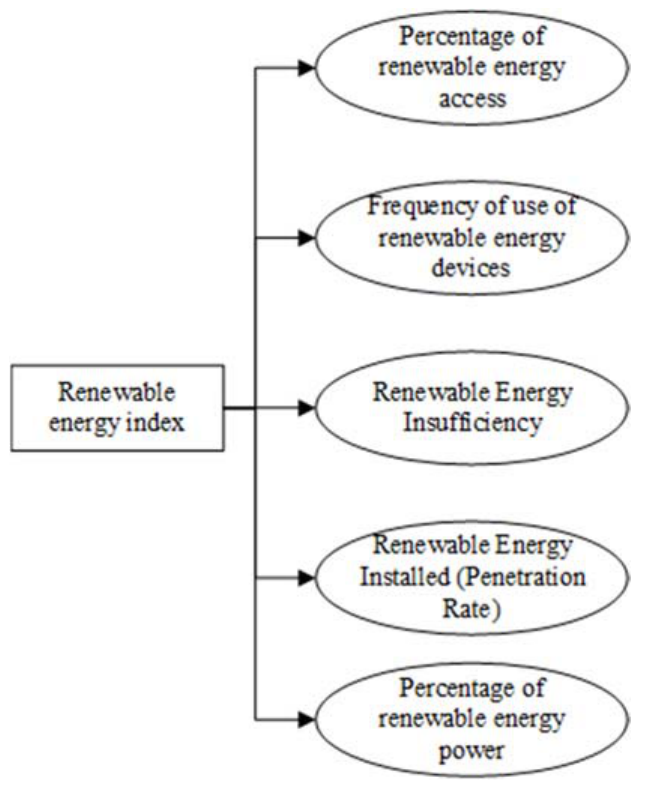
Figure 1. The renewable energy index.